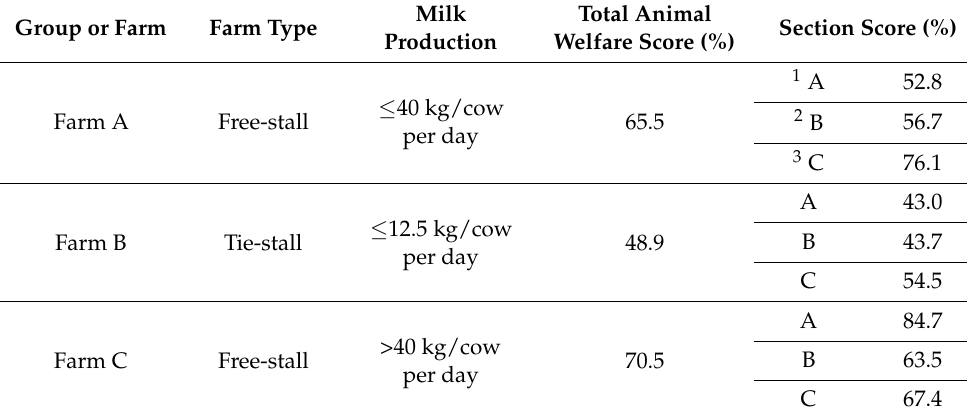
Table 2. Total animal welfare scores and section scores in the on-farm animal welfare assessment. Section and total welfare scores are expressed in percentages from 0 to 100, where 0 denotes a poor level or poor animal welfare status and 100 denotes an excellent section level or optimal animal welfare status.